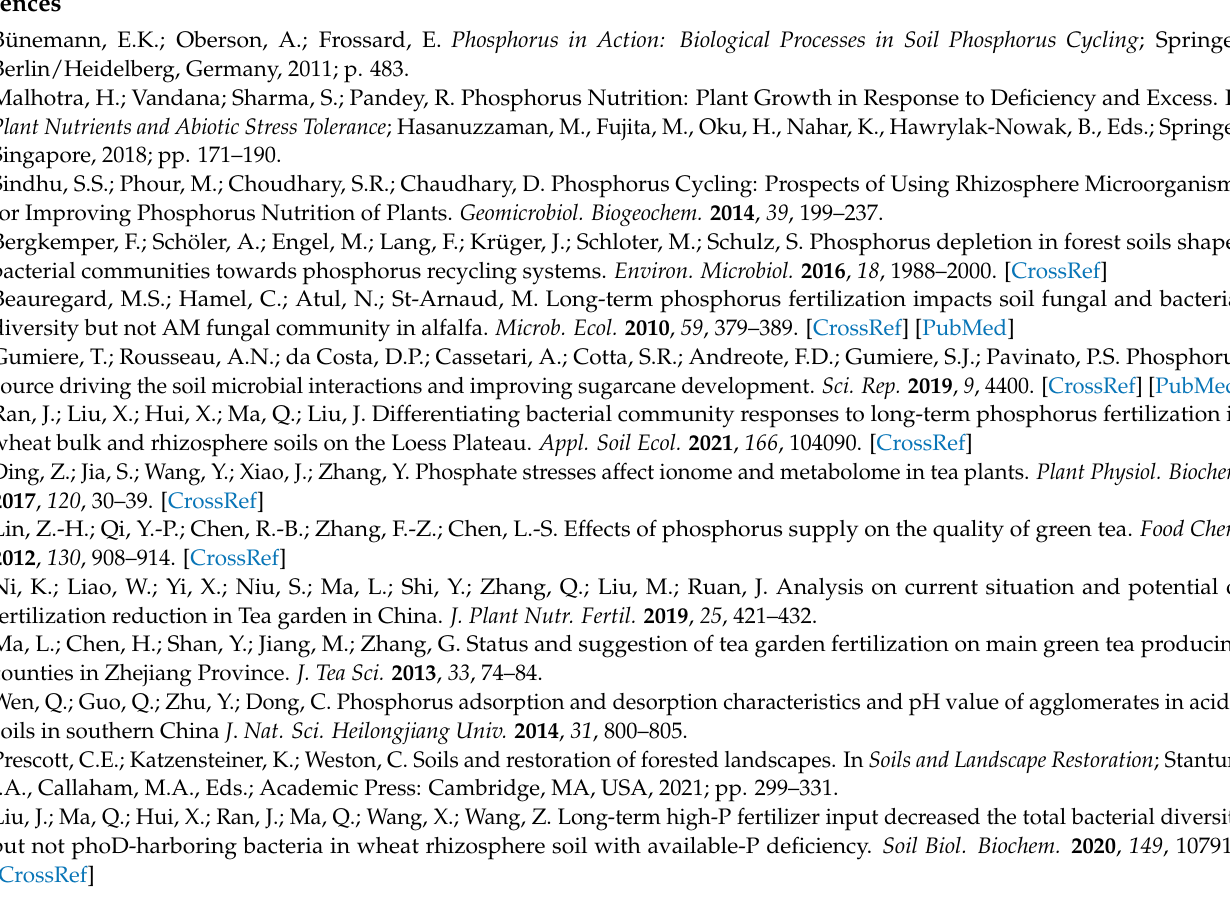
first ten rhizosphere bacteria; Figure S2: The relative abundance of the first ten rhizosphere fungi; Figure S3: Effect of phosphorus fertilizer addition rate on AMF. Table S1: Functional gene pathway differences (mean ± standard error); Table S2: Highly probable ZOTUs identified by